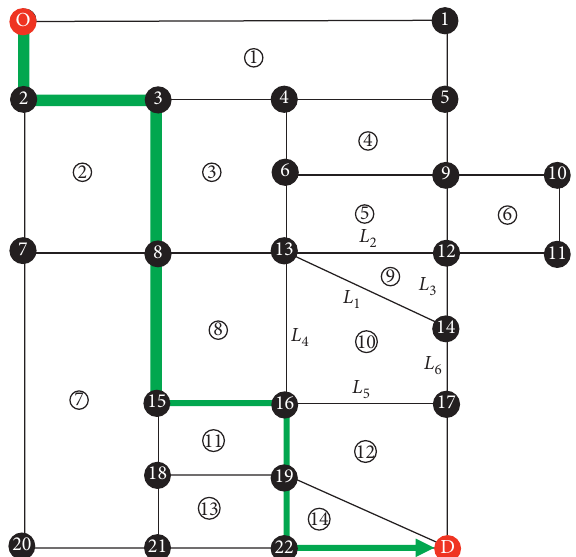
Figure 1: Logistics transportation truck path optimization